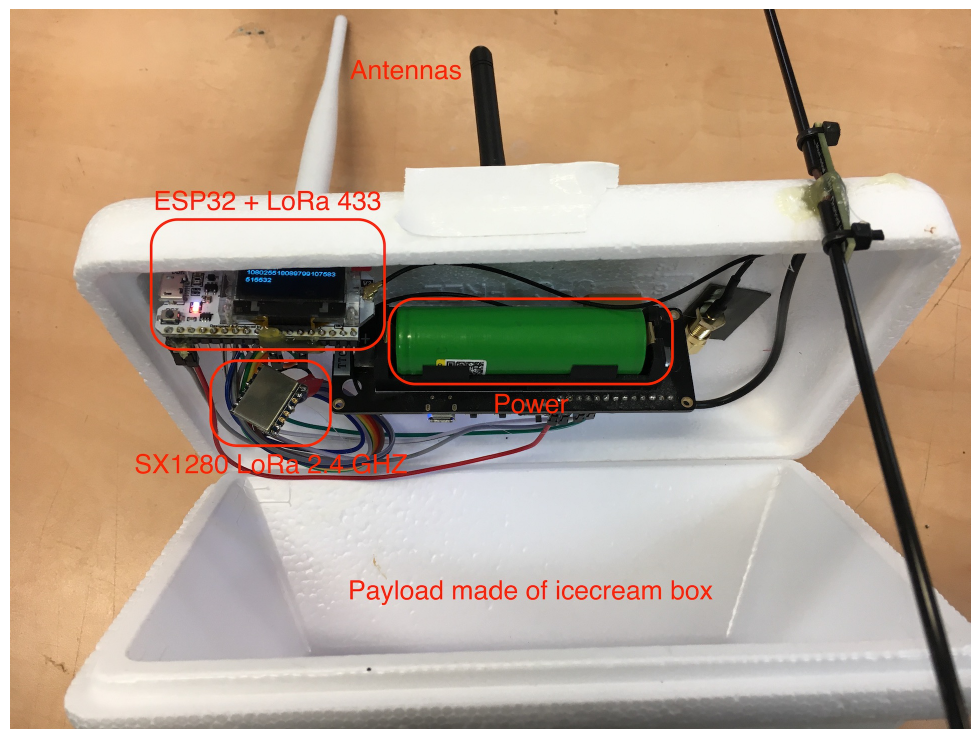
Figure 10. The payload for the long-distance ranging experiment included the LoRa SX1280 2.4 GHz and the LoRa 433 MHz for backup.